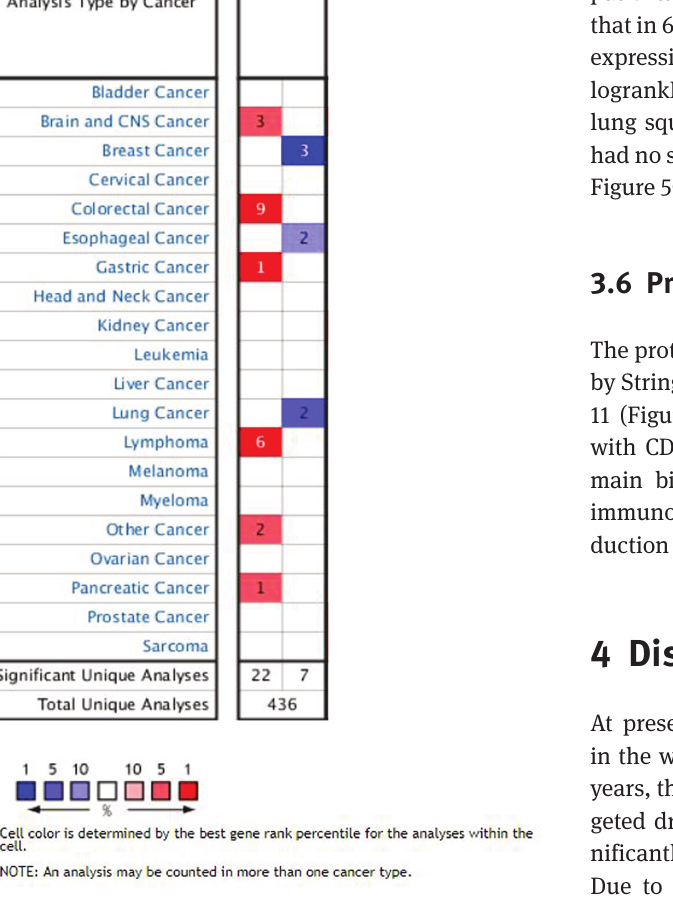
Figure 2: Expression of CD276 in common tumor